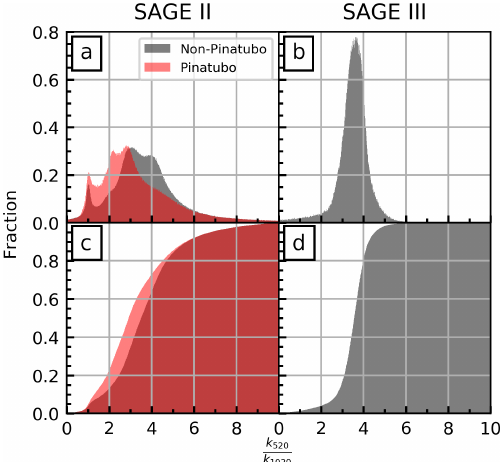
Figure 3. Extinction ratio PDFs (panels a and b , bin width is 0.01) and CDFs (c, d) for the SAGE II and SAGE III missions. Due to the impact of the Pinatubo eruption, separate histograms were cre- ated for the SAGE II panels. Only stratospheric altitude (tropopause + 2km) were used to generate this figure to ensure exclusion of cloud contamination. In the SAGE II panels (a, c) , light red indi- cates data impacted by the Pinatubo eruption, gray indicates data not impacted by Pinatubo, and dark red is the overlapped region of the